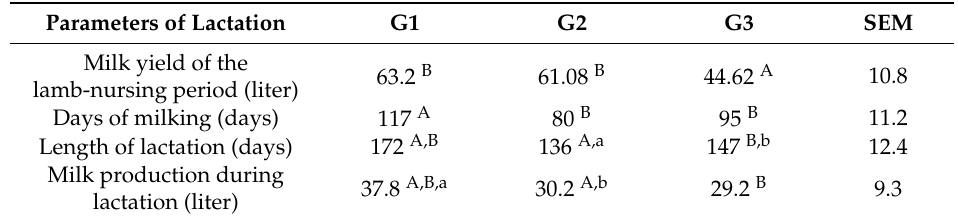
Table 1. The lactation parameters in sheep from the Group 1 (lambing in February–milked from April to August, Group 2 (lambing in June–milked from August to October), Group 3 (lambing in June–milked from August to November and melatonin-treated before 6 weeks parturition). Parameters of